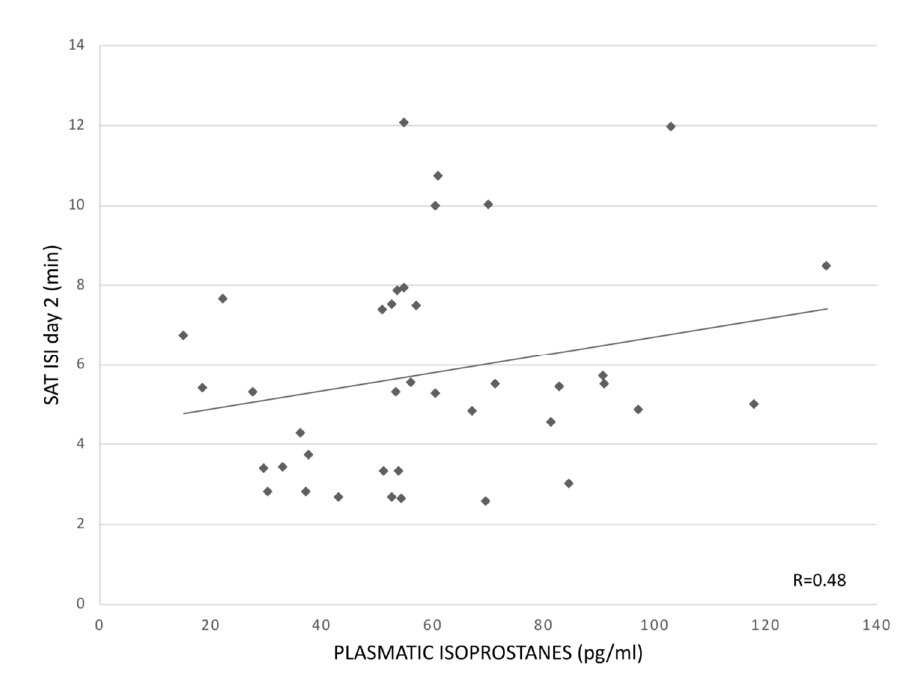
Figure 1. Association between pl-IPs between 24 and 48 h after birth and ISI at day 2 (sec/min) ( p = 0.023).